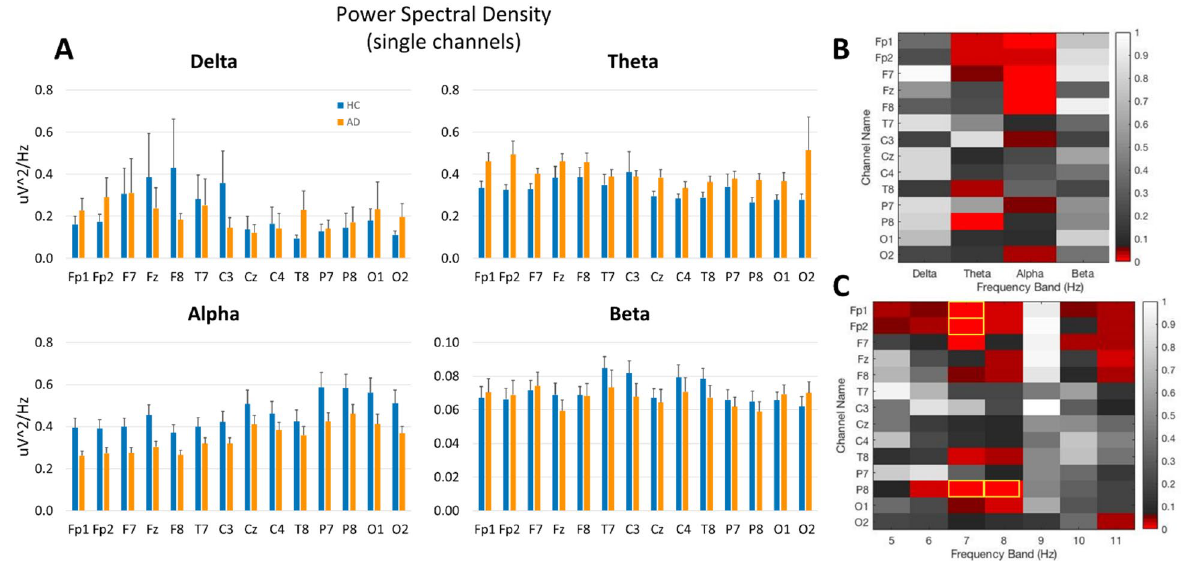
Figure 2. ( A ) Power spectral density in 14 individual EEG channels in HC (n = 23) and AD (n = 18) subjects in the delta, theta, alpha, and beta frequency bands. ( B , C ) Heat maps showing t-test values for individual channels in each band ( B ) and for each 1 Hz bin between 5 and 11 Hz ( C ), red hue indicates p < 0.05, and yellow rectangles indicate 4 features selected for machine learning based on the lowest p values. Figure generated using Matlab R2021b Update 3 (https:// www. mathw orks. com/).